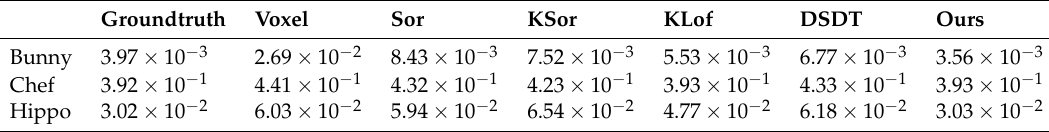
Table 1. Root mean square error (RMSE) comparison of generalized iterative closest point (GICP).